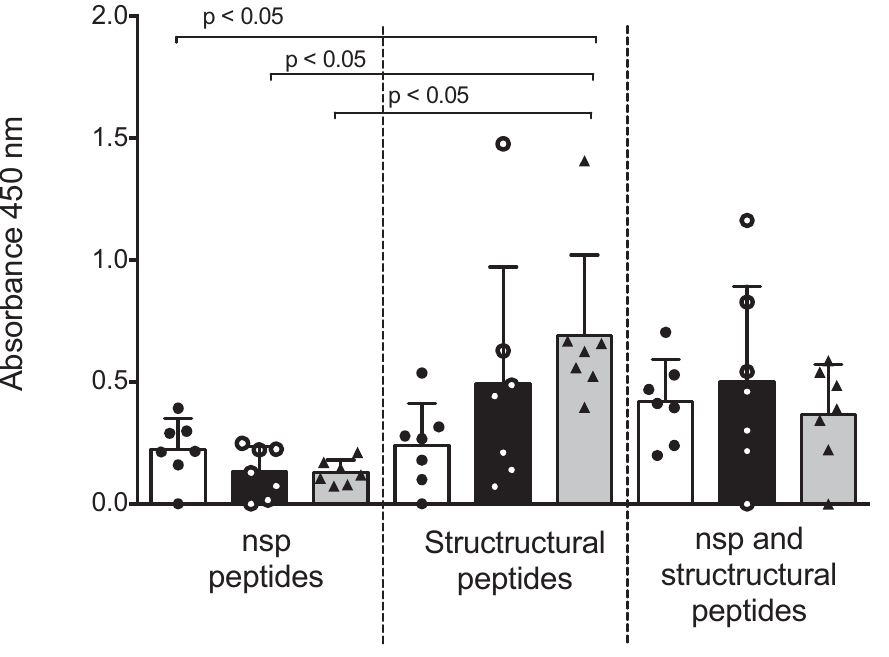
Figure 2. Antibody recognition of IFN-(cid:2) inducer peptides by multiparous and hyper-vaccinated sows. Humoral response in multiparous sows with the nsp peptides and structural protein peptides of PRRSV were detected in sera samples from sows ( n = 7 per group) by indirect ELISA. These data represent one independent experiment from a total of three with similar results and are expressed as the mean OD. Each bar represents the mean of the OD values of the sow sera ± standard deviation. Independent OD values were adjusted against the OD value from negative pig sera. White, black and gray bars represent the groups of sows with one, three and six parities,